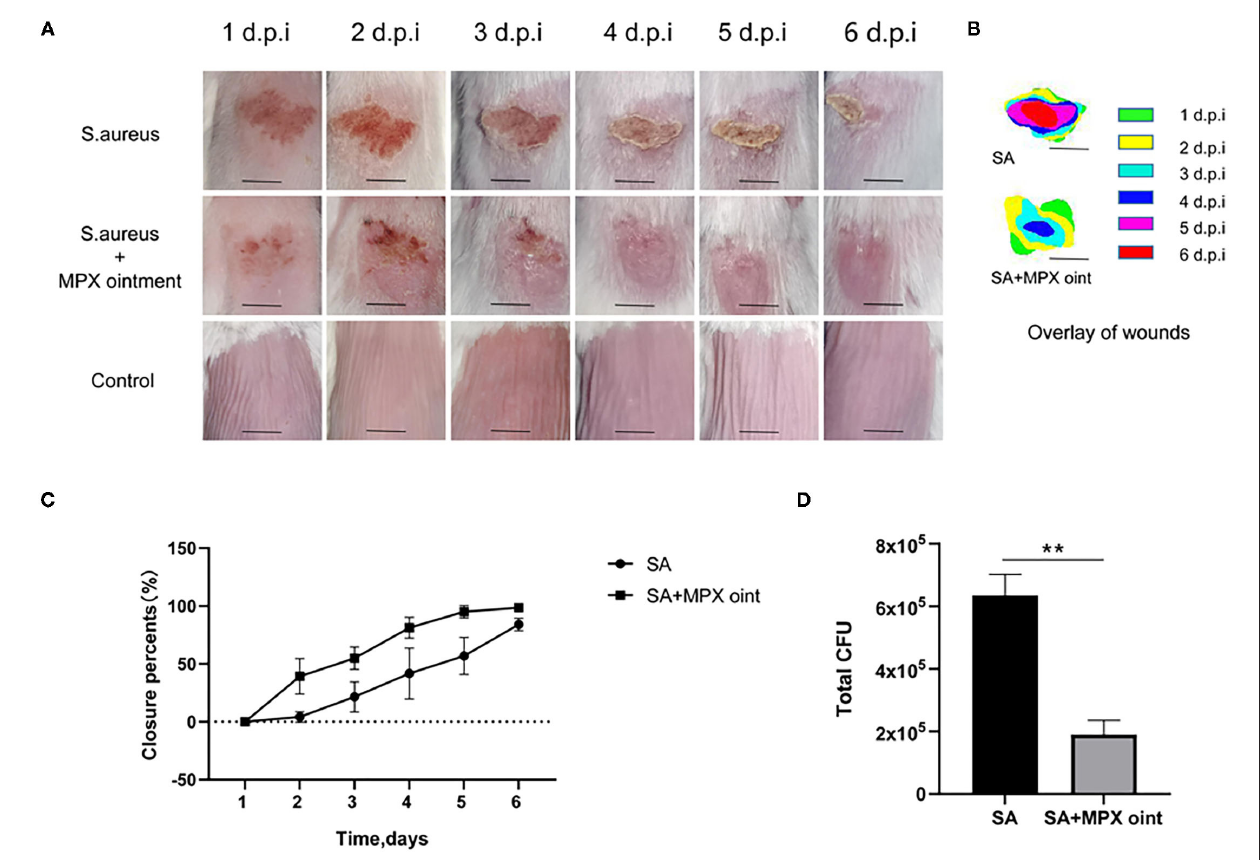
FIGURE 5 | MPX ointment can promote skin wound healing in mice infected with S. aureus ATCC 25923. Mice in each group were infected with S. aureus ATCC 25923 without treatment ( S. aureus /SA) or with treatment with MPX ointment ( S. aureus + MPX ointment/SA + MPX oint), and mice in an uninfected group did not receive any treatment (Control). (A,B) Wound pictures and superimposed pictures of mice infected with S. aureus 1, 2, 3, 4, 5, and 6 days later. The black line represents 0.5cm; d.p.i: days post infection. (C) Wound healing rate. (D) The number of colonies at the wound site after the sixth day of S. aureus infection. Error bars indicate the mean ± SEM, n = 3. Statistical significance was defined as ** p <